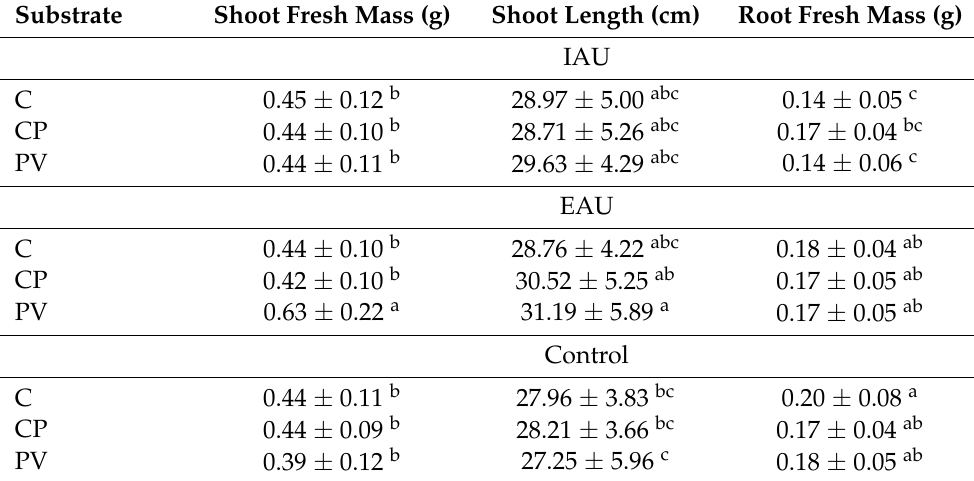
Table 7. Shoot fresh mass, shoot length, and root fresh mass of wheatgrass in different experimental groups, “Control”—fertilized tap water; “IAU”—fish effluents from intensive aquaculture unit; “EAU”—fish effluents from extensive aquaculture unit; “C”—100% coconut fibers; “CP”—70% coconut fibers + 30% perlite; “PV”—50% vermiculite + 50% perlite (mean ± SD, n = 3).